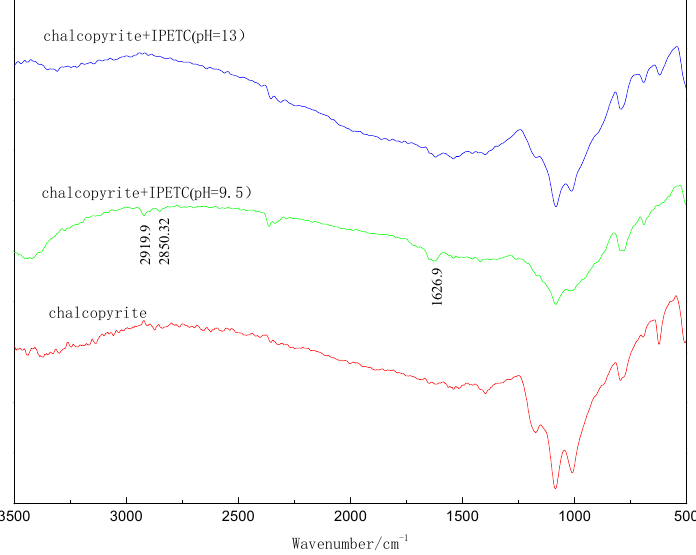
Figure 5. Infrared spectra of chalcopyrite with IPETC at different pH.